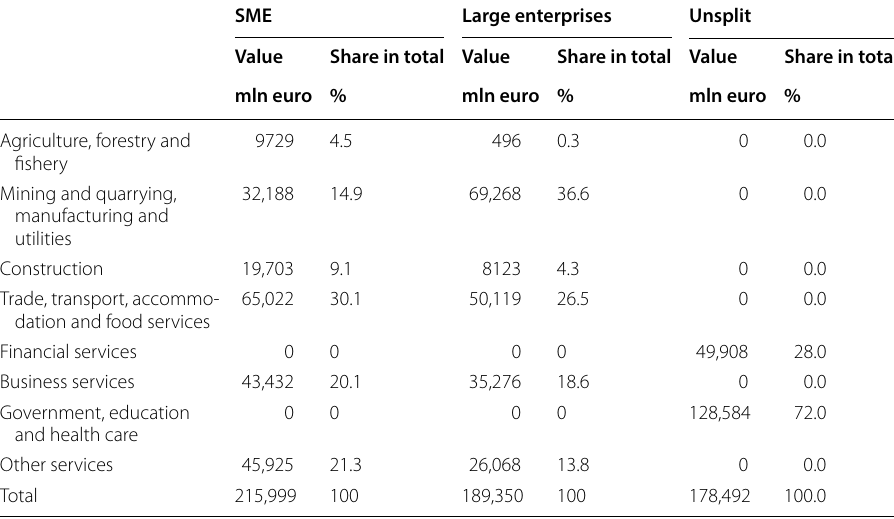
Table 2 Distribution of value added over industries, by size class, 2012 SME Large enterprises Unsplit Value Share in total Value